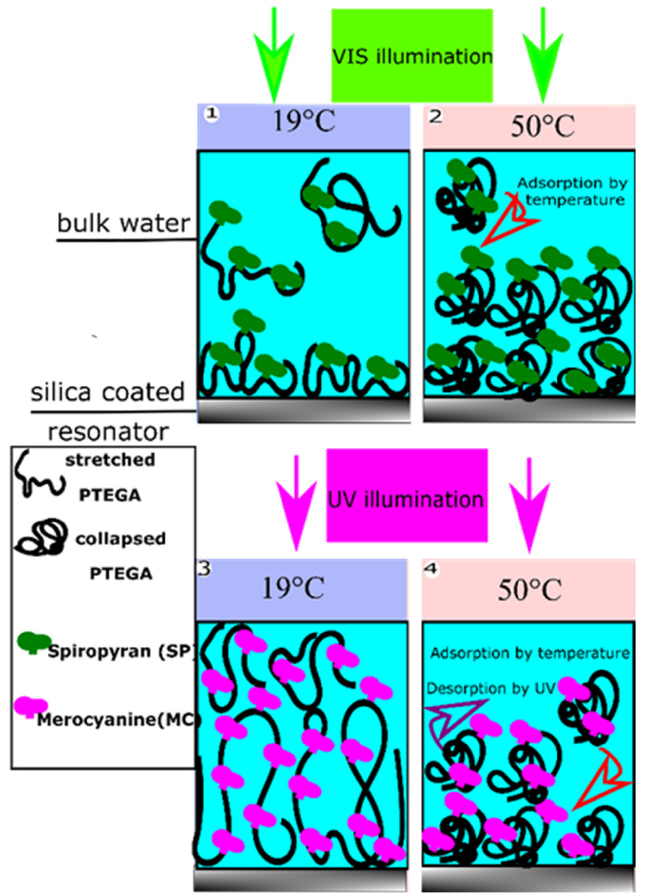
Figure 1. Coil to globule transition at different temperatures shown by way of example for the dual light and temperature responsive P (TEGA-co-SP/MC) copolymer during in situ observation of adsorption and film formation on a silica surface by QCM-D.